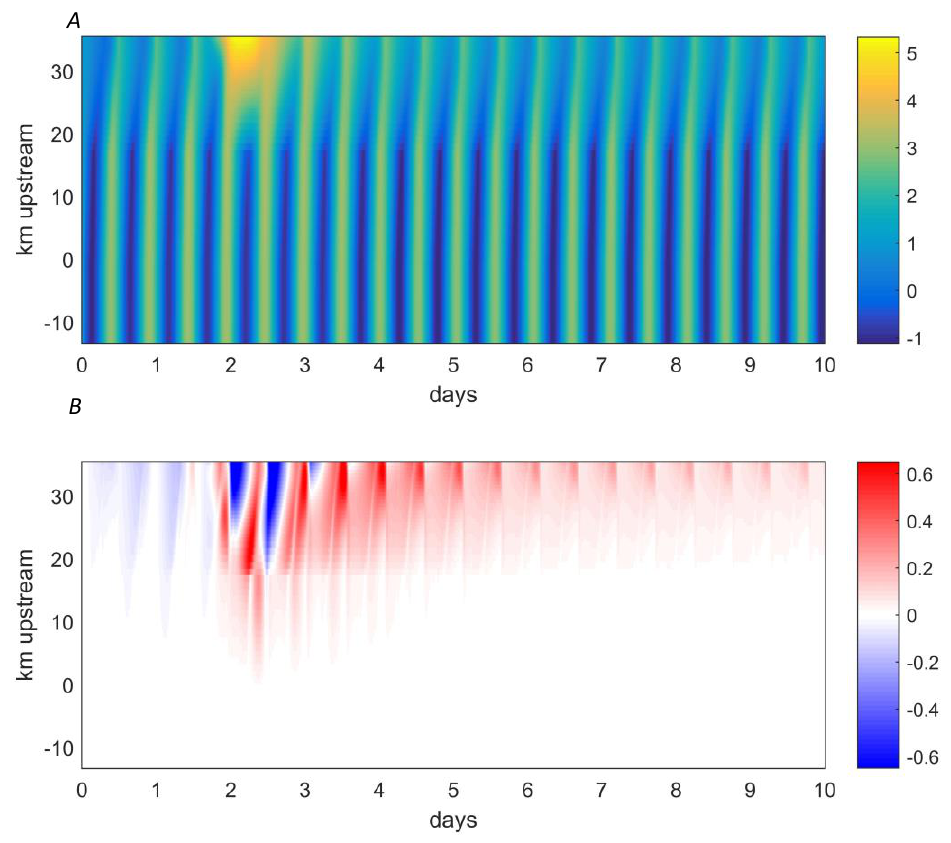
Figure 10. The sum of the parts is greater than the parts combined. ( A ) Water level in time (x-axis) and space (y-axis) with color indicating value in meters for model run I8, which has the highest water level of all the idealized scenarios. ( B ) The same x and y axes as in A. Color indicates the difference between I8 (the full storm) and the “simple prediction” referenced in the text.